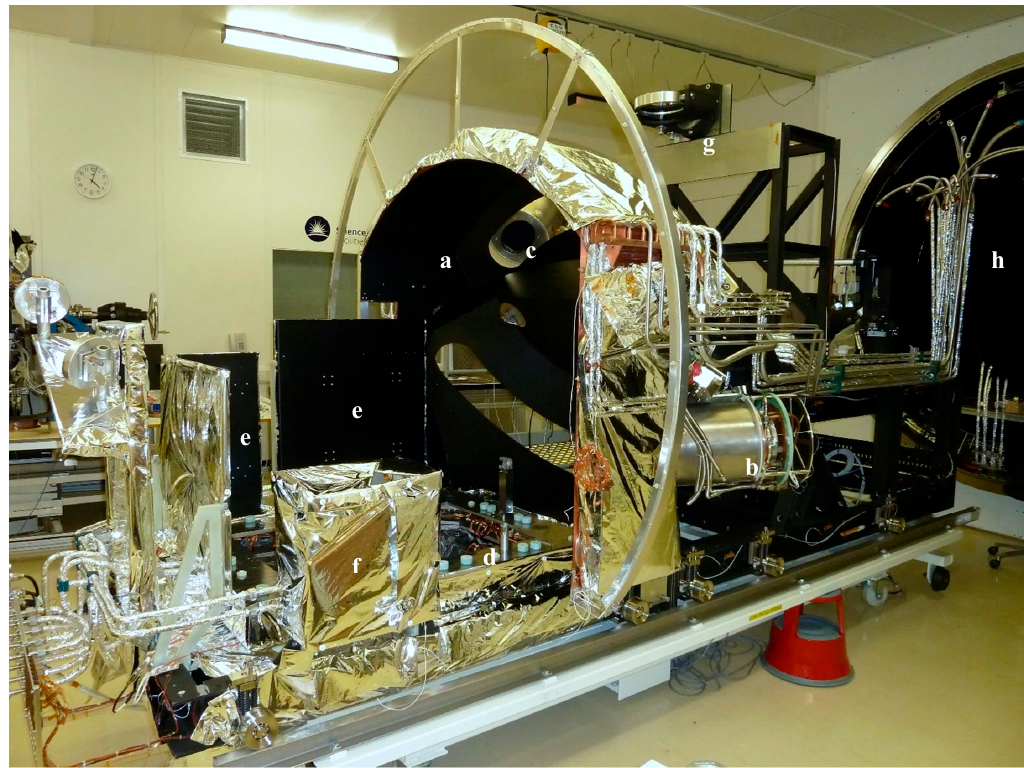
Figure 2. SLSTR calibration rig under preparation for thermal testing showing the main components. ( a ) earth shine plate, ( b ) nadir view BB source, ( c ) oblique view BB source, ( d ) spacecraft simulator, ( e ) cold thermal panels, ( f ) instrument electronics enclosure, ( g ) field of view optics and ( h ) space test chamber.